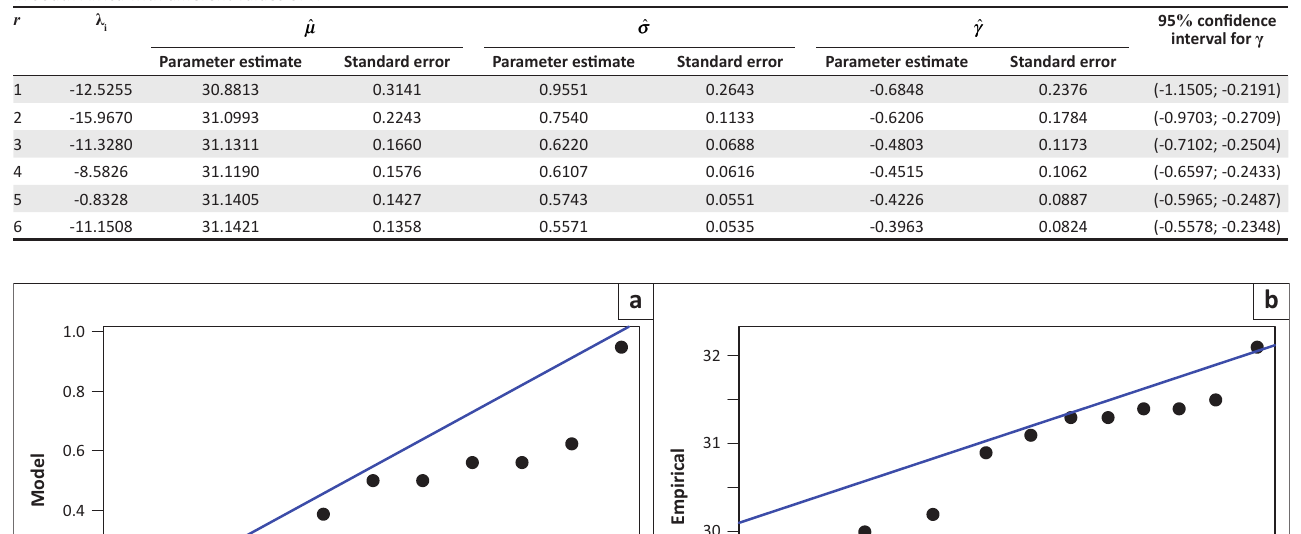
TABLE 1: Maximised log-likelihoods λ